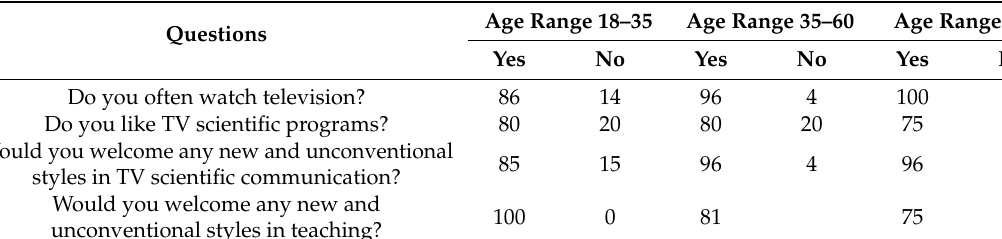
Figure 4. Diagram of Personal interest in Sciences. Table 3. Table of personal approach to TV programs.